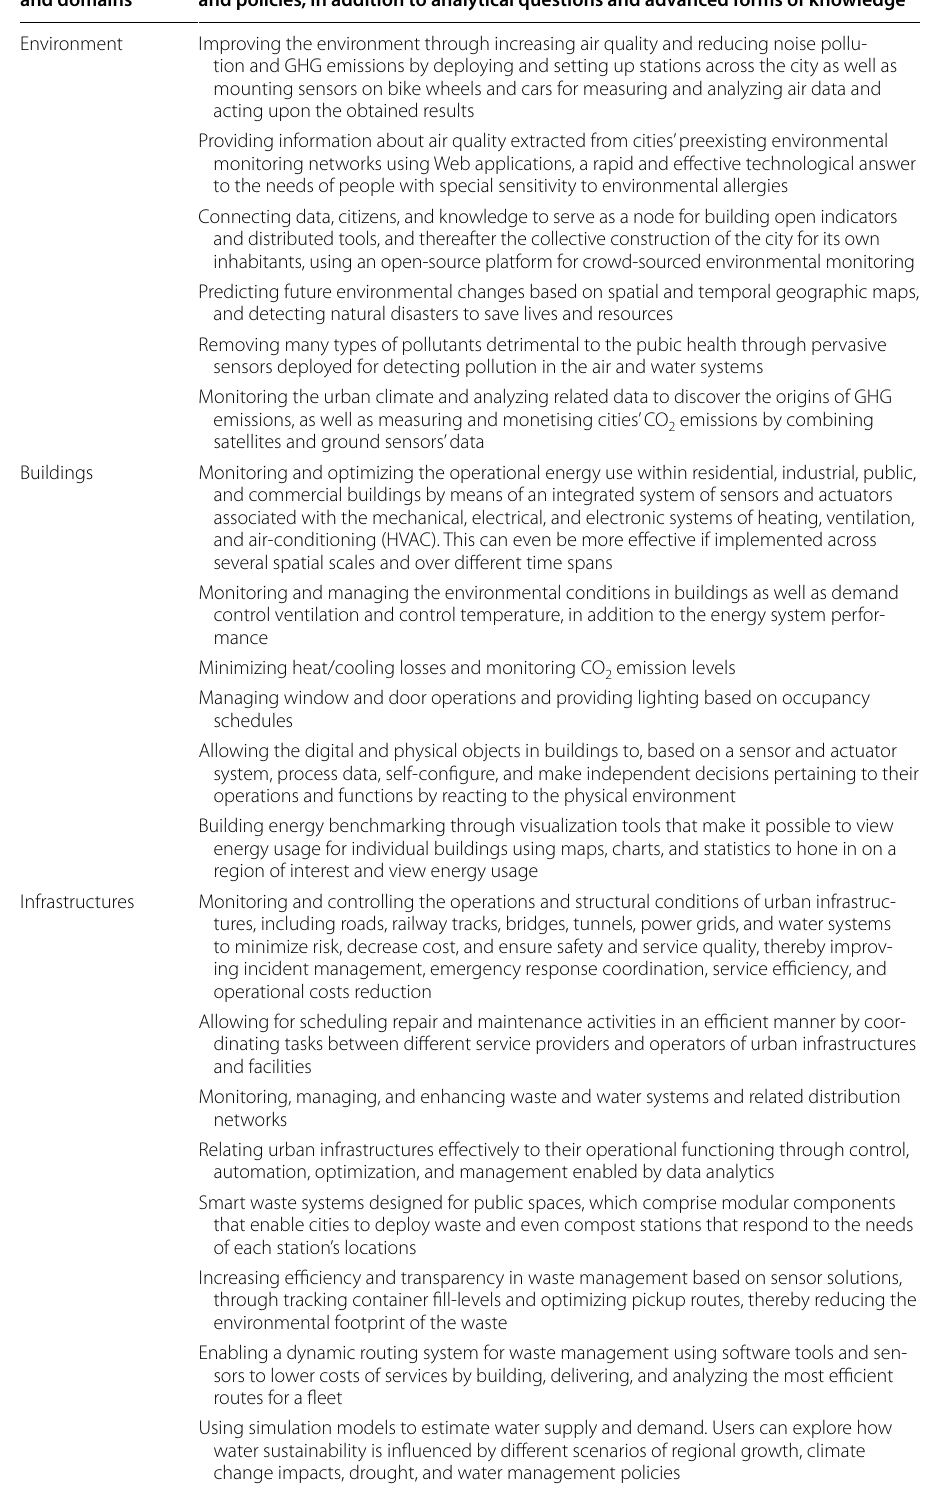
Big data applications: operations, functions, services, designs, strategies, and policies, in addition to analytical questions and advanced forms of